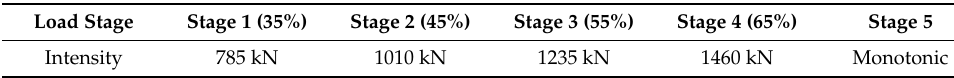
Table 8. Repeated loading test programs.